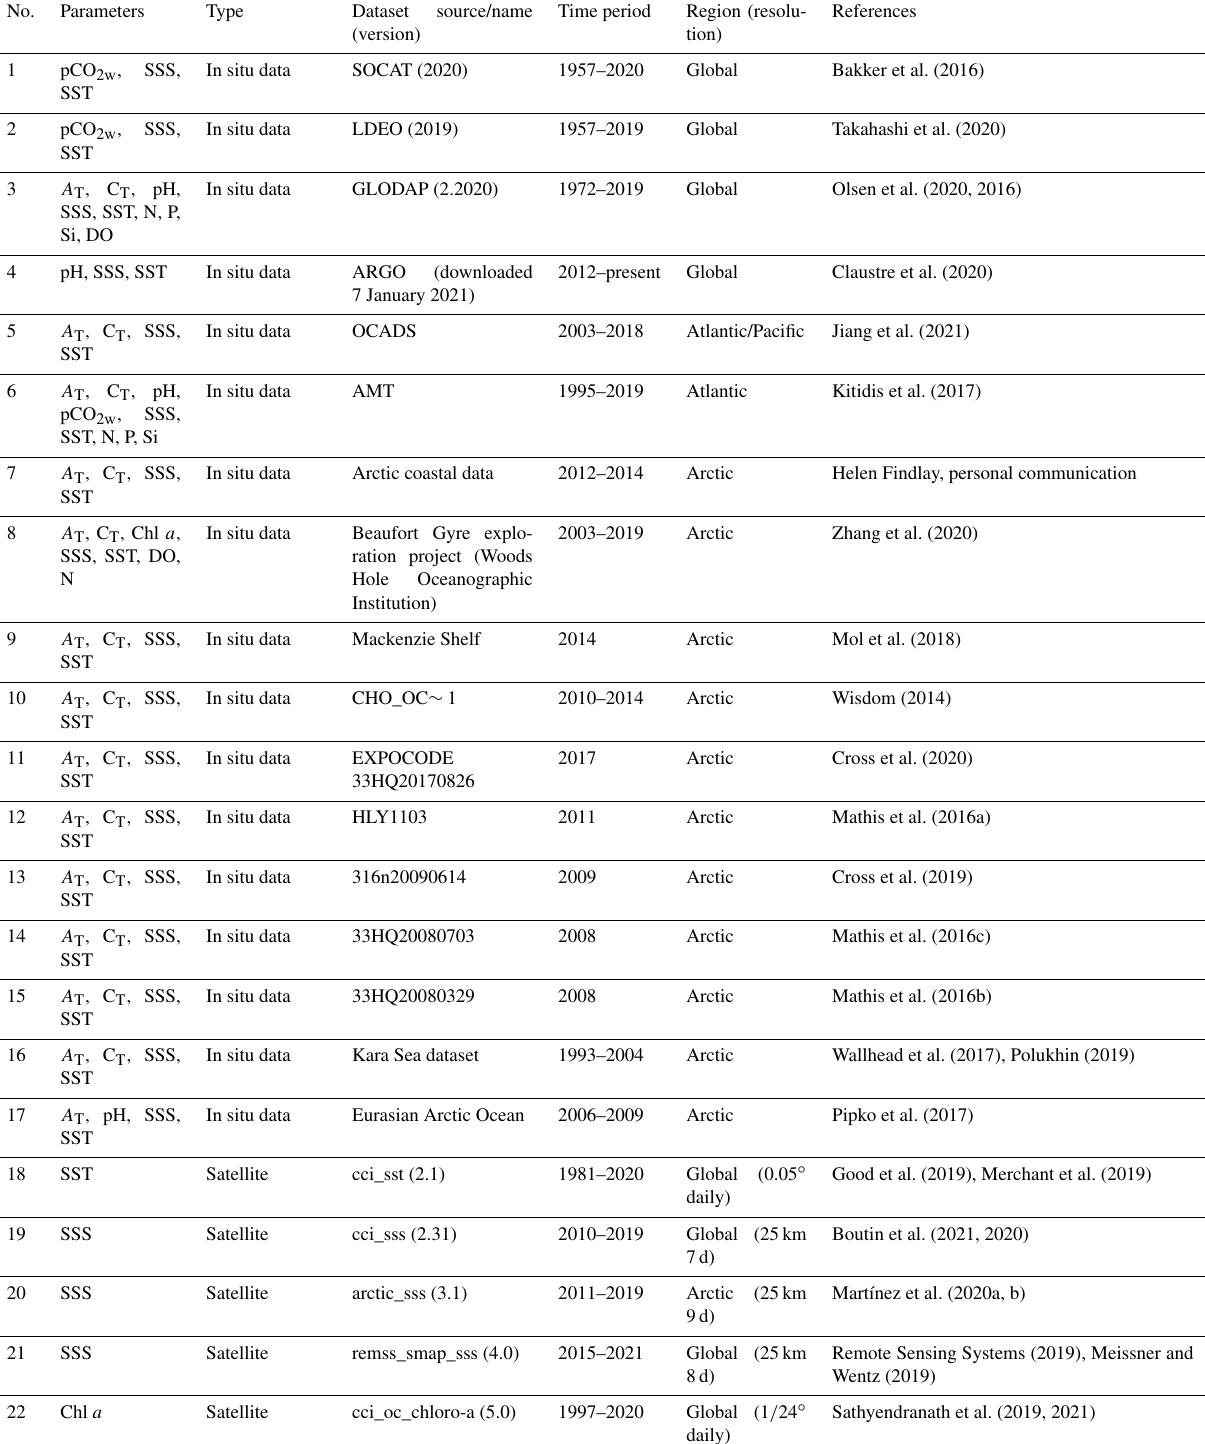
Table 1. Input data sources for various parameters (SST: sea surface temperature, SSS: sea surface salinity, Chl a : chlorophyll a , DO: dissolved oxygen, N: nitrate, P: phosphate, Si: silicate, A T : total alkalinity, C T : total dissolved inorganic carbon). Lines 1 to 17 are in situ datasets which are used to create the regions of interest; hence they do not have unique dataset names. Lines 18 to 28 are generated using felyx, so each has a unique dataset